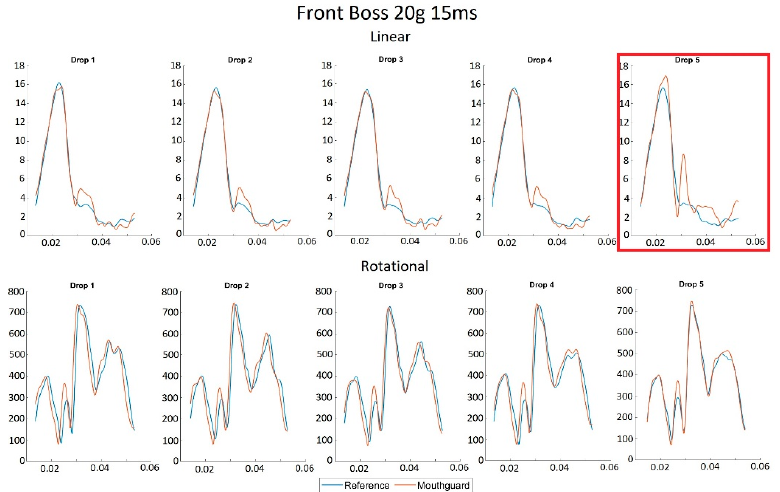
Figure 5. Each impact in the 20 g, 15 ms front boss scenario with the outlier marked. Minimal differences were found between the correlation coefficients of linear and rotational accelerations (Table 2). There was no significant difference (t (118) = 0.42, p = 0.68, d = 0.11) between the relative peak acceleration errors for linear and rotational accelera- tions. Table 2 also shows the means and standard deviations of peak and RMS errors, found by taking the mean and standard deviation of all the impacts. Table 2. Measurement statistics.